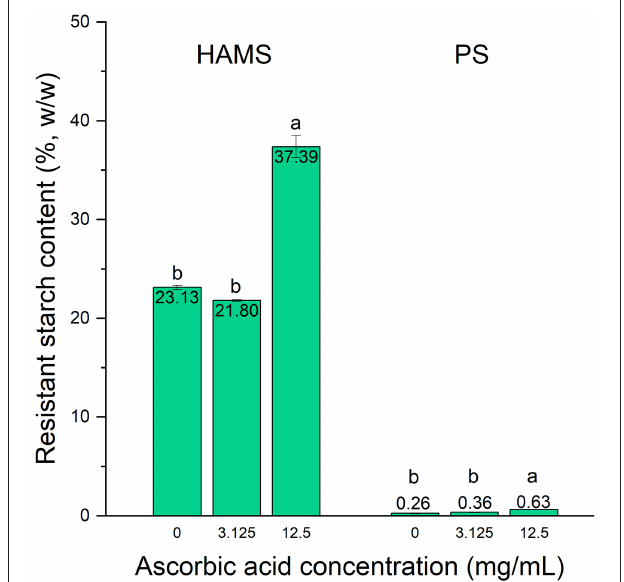
FIGURE 2 | Resistant starch contents in high amylose maize starch (HAMS) and potato starch (PS), presented as a proportion of total starch, with the presence of ascorbic acid with concentrations of 3.125 and 12.5 mg/mL upon cooking. Error bars show standard deviation; n = 2. Significant differences among treatments are denoted by different letters (a > b, p <